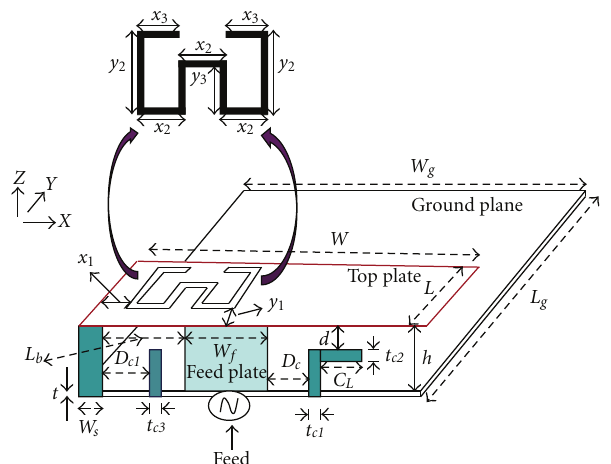
Figure 1: PIFA geometry.